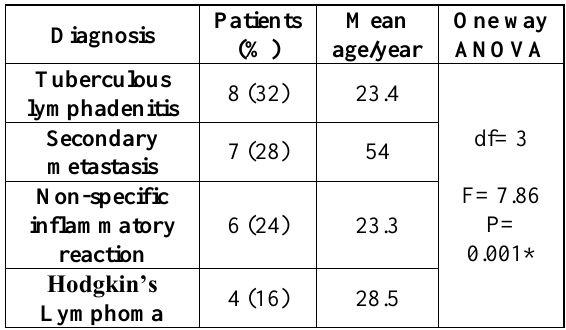
Table 2: Summary of the etiologies